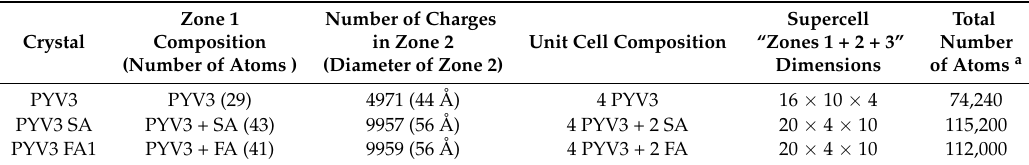
Table A1. Parameters used in the Ewald program.